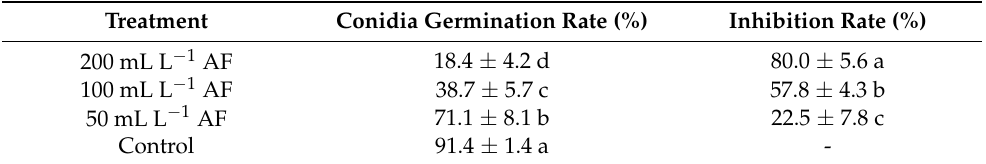
Numerical values were expressed as mean ± standard error (SE) of triplicates. Different lowercase letters represented a significant difference ( p <